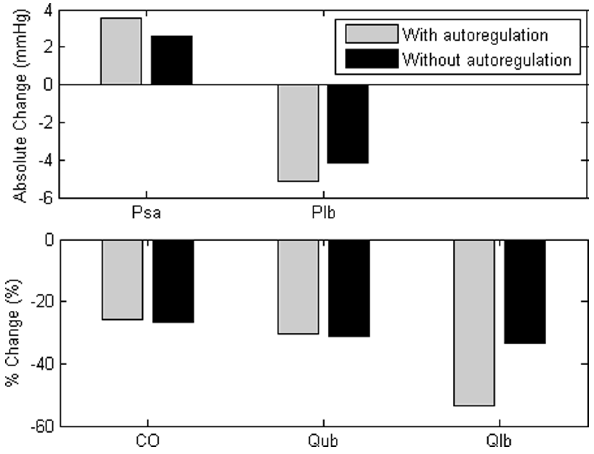
Figure 5. Effect of autoregulation on arterial pressure ( P sa ), pressure in the lower body compartment ( P lb ), cardiac output ( CO ) and flows in the upper and lower body compartments ( Q ub & Q lb ). Absolute value changes in the arterial pressure ( P sa ) and pressure in the lower body compartment ( P lb ), as well as percentage changes in the cardiac output ( CO ), flows in the upper and lower body compartments ( Q ub & Q lb ) from the supine position to 70 o HUT for the healthy condition, with and without the autoregulatory